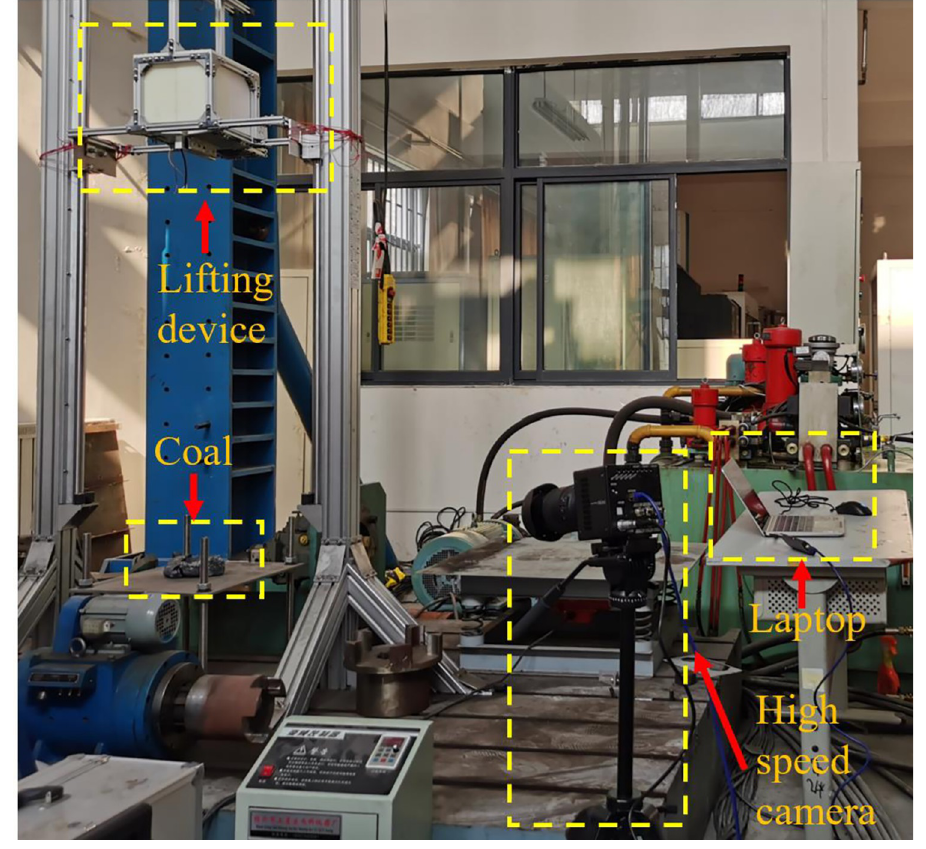
Fig 4. The coal falling test.